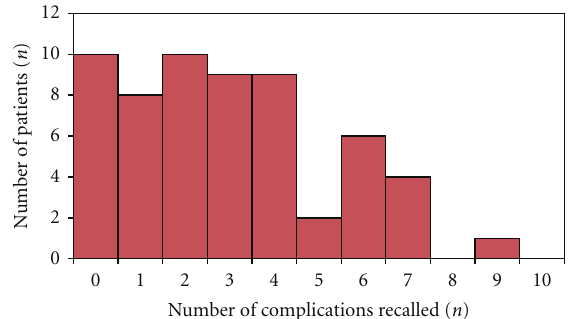
Figure 1: Histogram of number of complications recalled at time of admission for procedure.